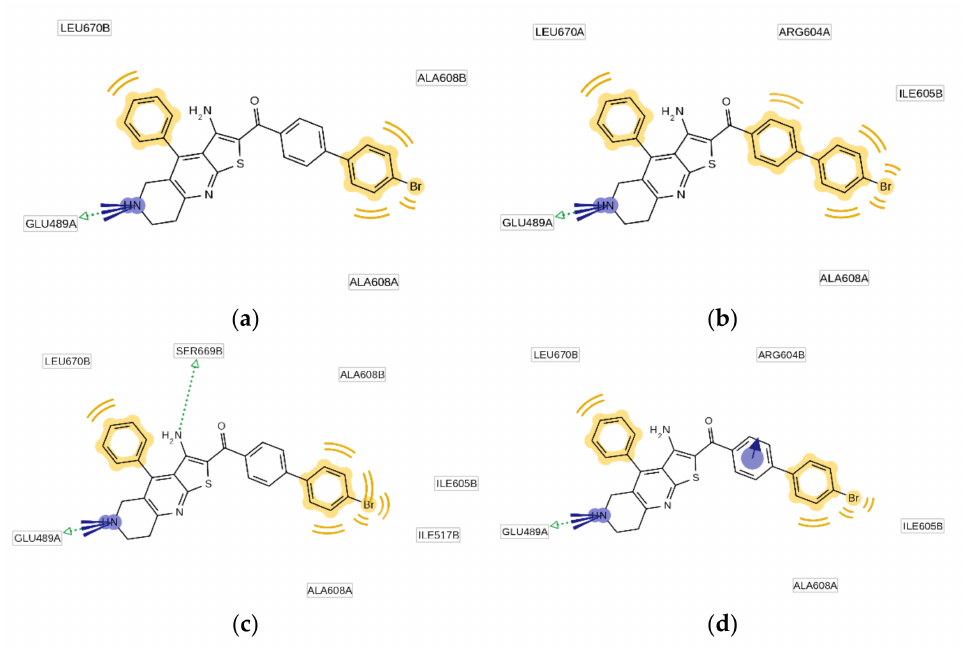
Figure 9. Schematic representation of the four most frequently appearing pharmacophore models during the MD trajectory ( a – d ).